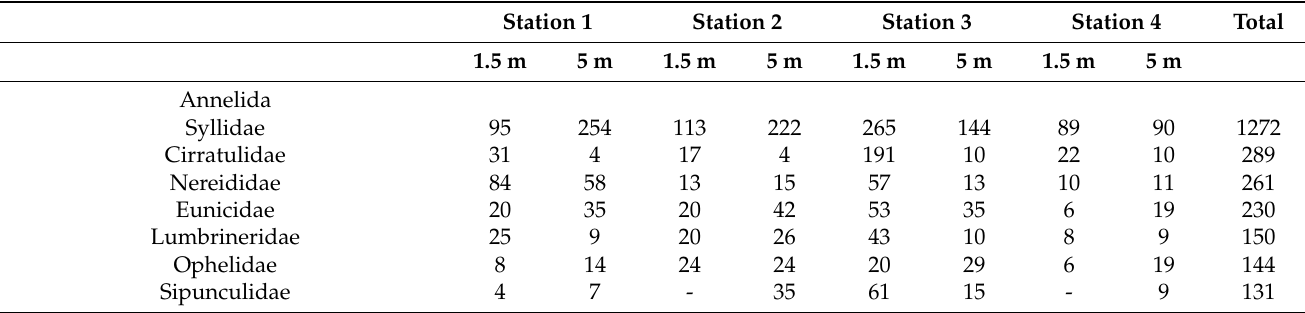
Table A2. Abundance (number of individuals) of macrobenthic taxa other than Sabellida collected at Torre Guaceto